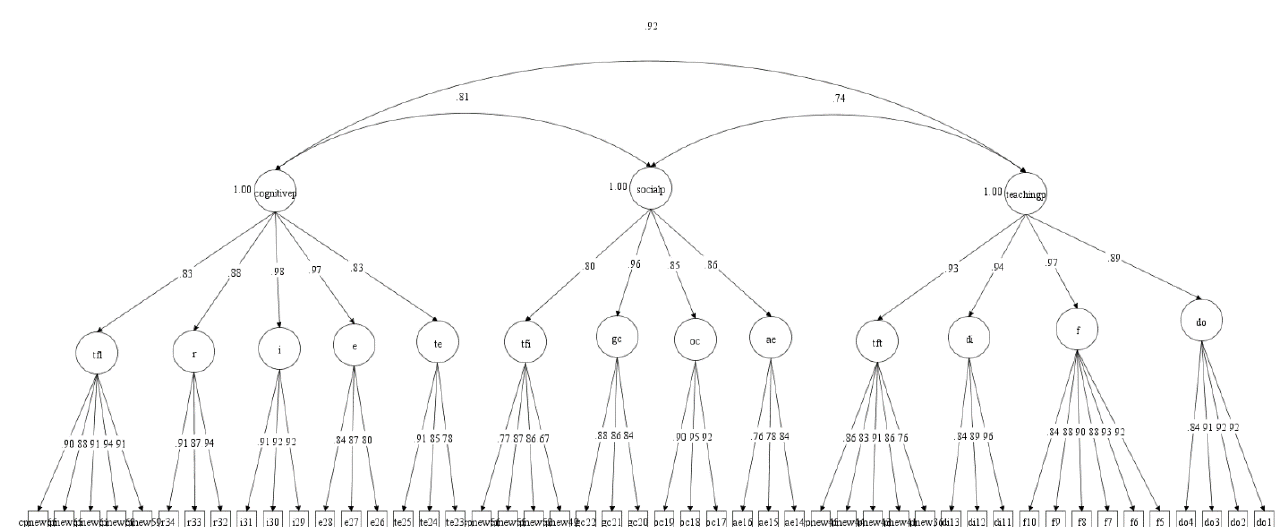
Second-Order Confirmatory Factor Analysis for the Extended CoI